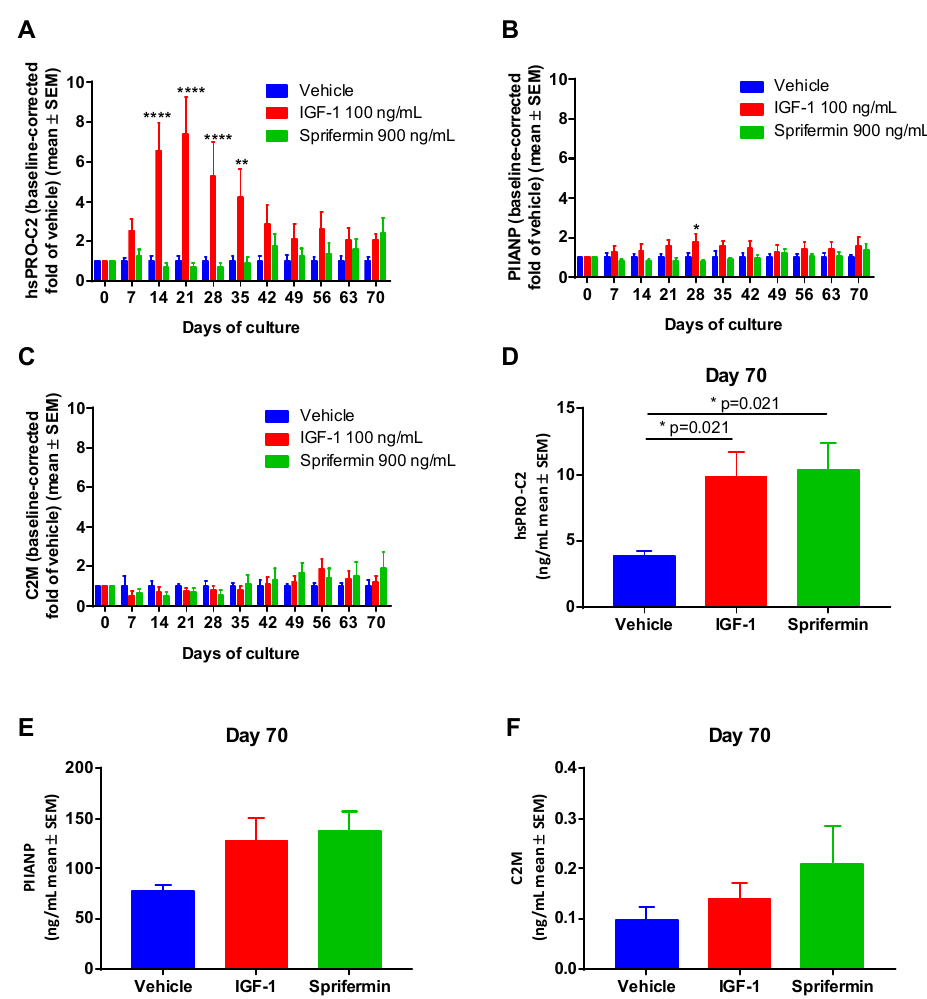
Figure 3. hsPRO-C2 ( A , D ), PIIANP ( B , E ) and C2M ( C , F ) measured in the supernatant of human articular cartilage explants cultured for ten weeks in the presence of growth factors (IGF-1 and sprifermin) compared to the vehicle group. The values in panels ( A – C) and panels ( D – F) were compared with ordinary two-way analysis of variance (ANOVA) and one-way ANOVA test (not repeated measures) respectively. Asterisks indicate the following: * p < 0.05, ** p < 0.01, **** p < 0.0001.